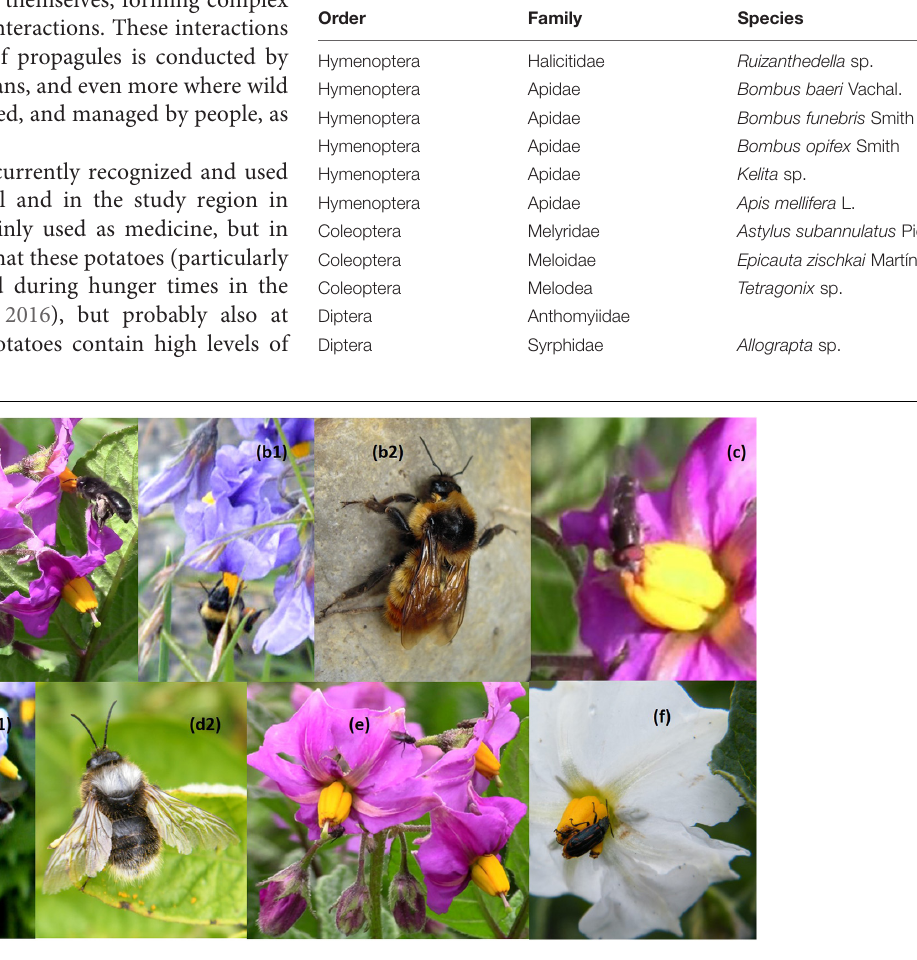
FIGURE 6 | Flower visitors shared by wild and cultivated potatoes studied. Some of the species identified visiting flowers of wild and cultivated potatoes sighted through the videorecording study of frequency, effectiveness, and duration of visits. (a) Kelita sp., (b1) Bombus opifex, (b2) detail of Bombus opifex © Alfredo F. Fuentes CC BY-NC 4.0. (Ueda, 2020) (c) Allograpta sp., (d1) Bombus funebris (d2) detail of Bombus funebris , (e) Anthomyiidae, (f) Astylus subannulatus .